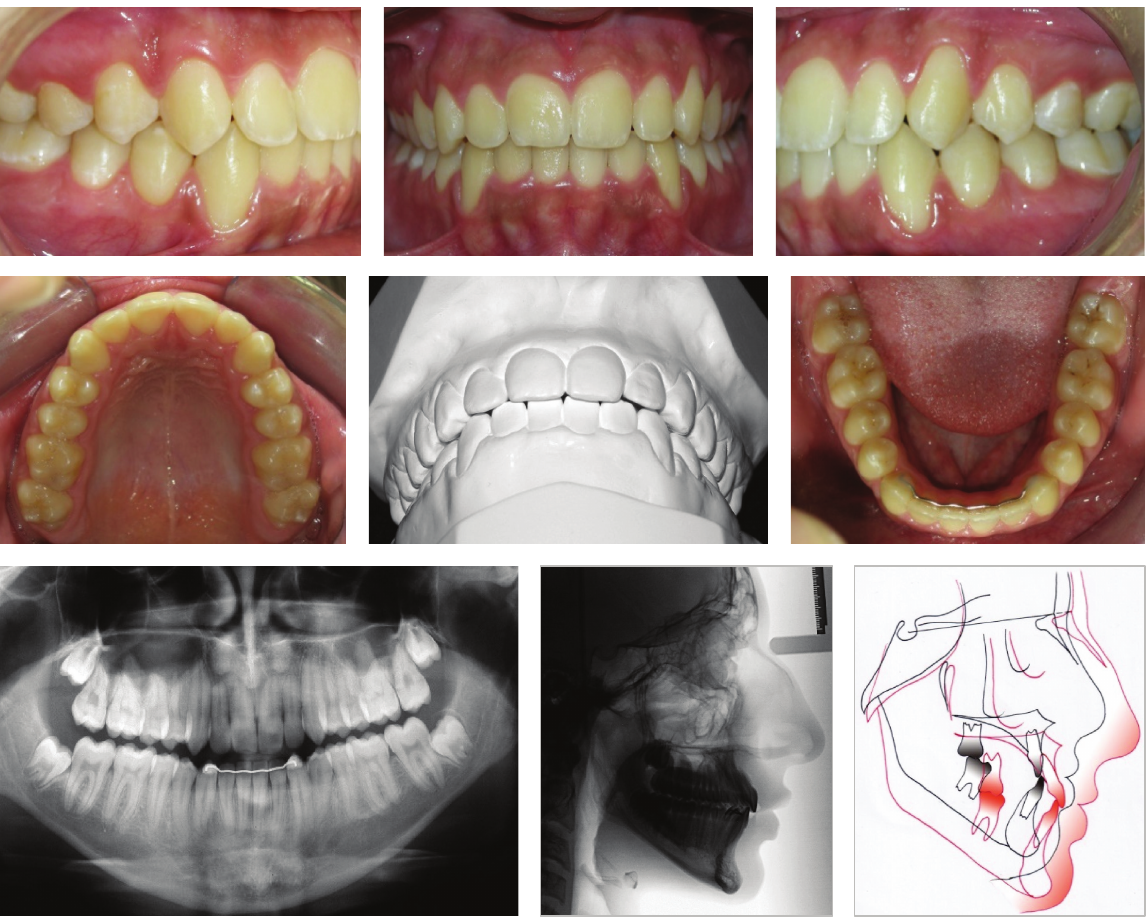
Figure 4: Posttreatment intraoral photographs. Good intercuspidation and adequate overjet and overbite. The skeletal and dental characteristics remained. Superimposition: pretreatment, black; posttreatment,